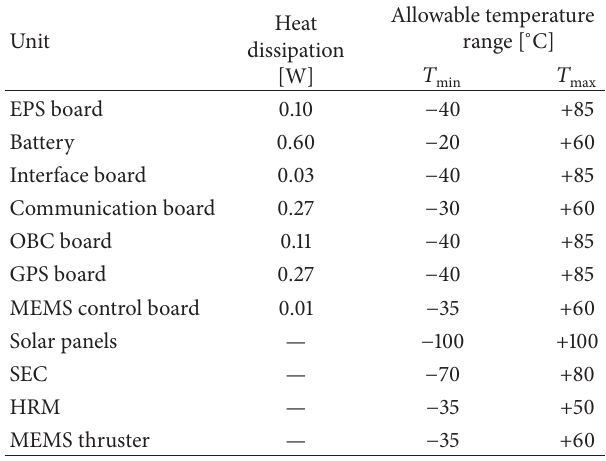
Table 2: Specification of mission payloads for STEP Cube Lab. Payload Specification